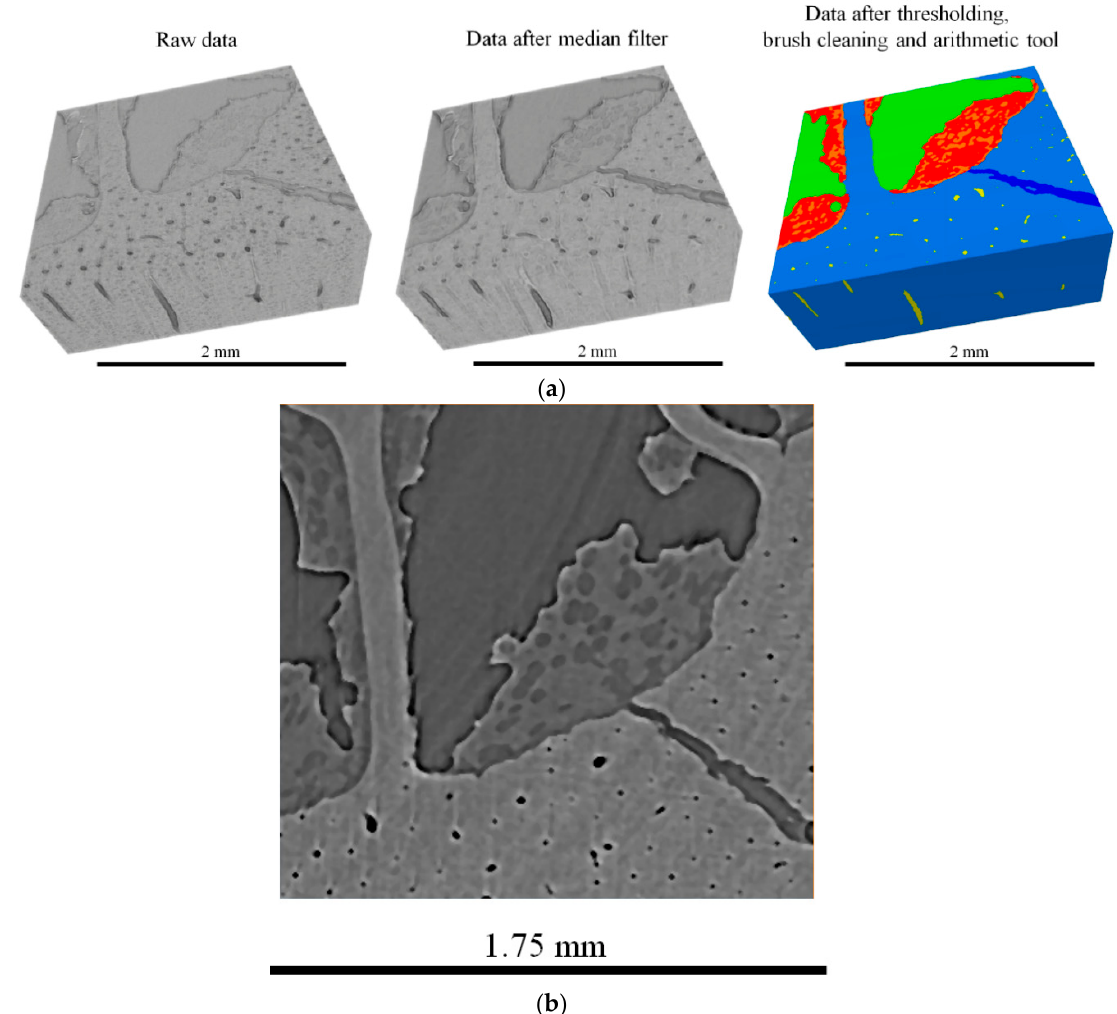
Figure 7. ( a ) Segmentation data processing steps; and ( b ) detail showing simultaneous capability of microscale visualization of cells in bone marrow, and cortical bone structure (Haversian canals).